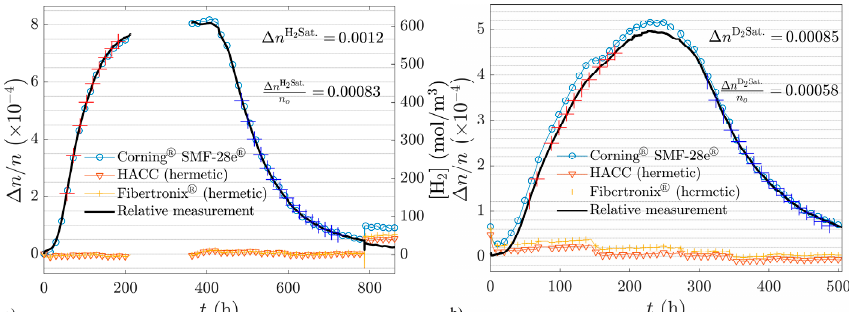
Figure 16. (From [47]) ( a ) Relative refractive index evolution due to the hydrogen loading (150 bars) as registered at the different fiber samples. The difference between the permeable and one of the hermetic fibers is shown (relative measurement); ( b ) equivalent deuterium experiment (100 bars). The red and blue crosses represent exponential fittings of the relative measurement curves. @2019 SPIE [47].